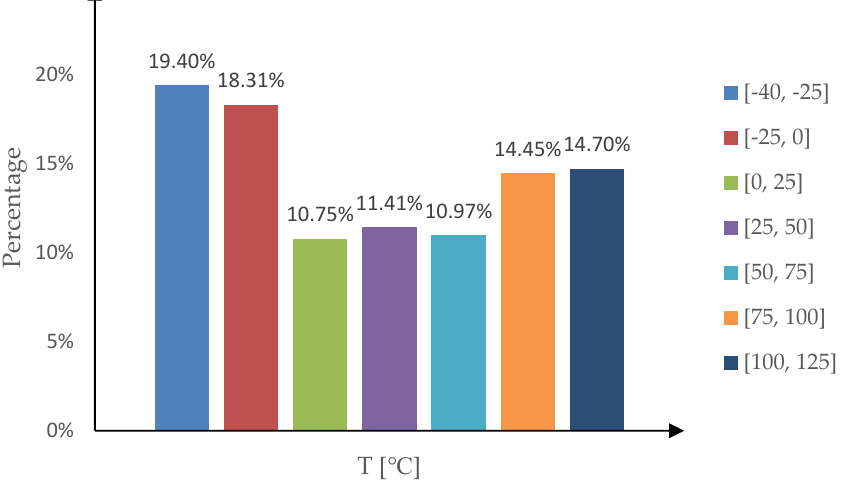
Figure 7. Temperature distribution of the test data with an RE greater than µ + 3 σ . The test data with an RE greater than µ + 3 σ accounted for 1.50% of all test data.